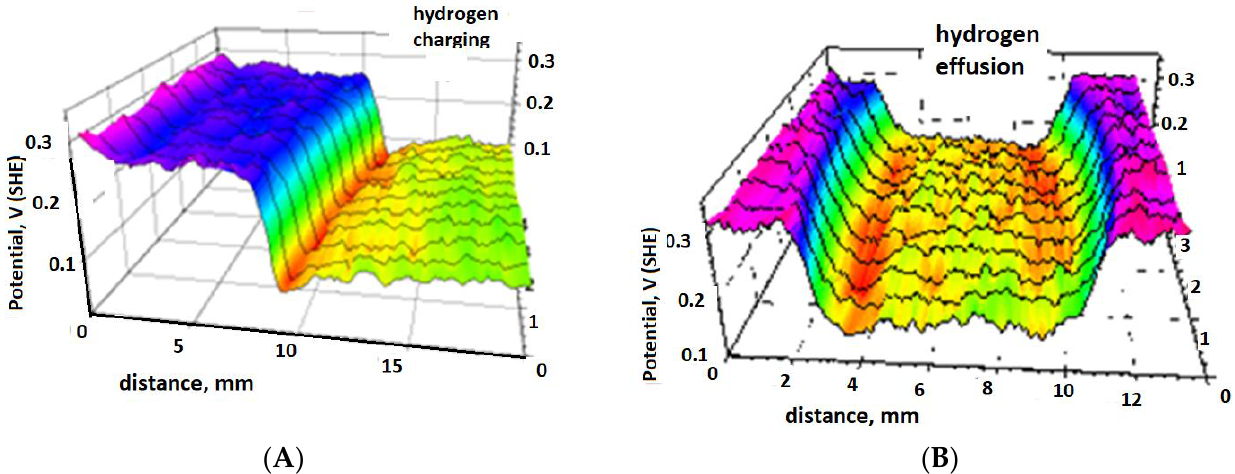
Figure 8. Potential distribution of mild steel SAE 1008, directly polarized ( A ) and permeation ( B ) sides of the membrane. The steel was locally pre-polarized for 1.5 h in 0.1 M NaOH aqueous electrolyte using a current density of − 5 mA/cm 2 . SKP measurements were carried out in air at 60%RH 3 h after treatment.